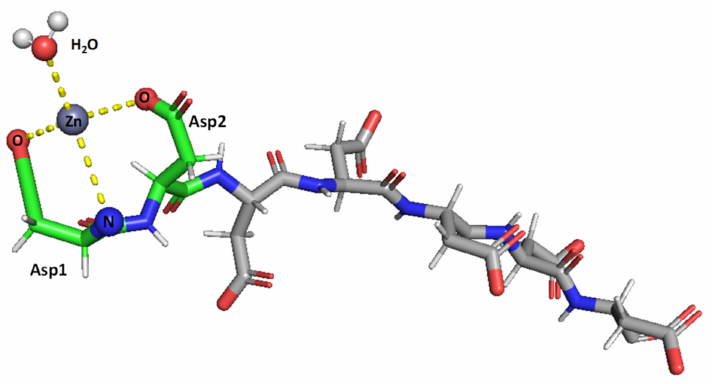
Figure 7. Suggested mode of coordination for Zn(II)-SAAP3 at pH 8. Zn(II) is bound by two carboxylates from aspartic acid side chains and by the N-terminal amine. A water molecule is also bound to create tetrahedral coordination. Figures were generated using PyMOL